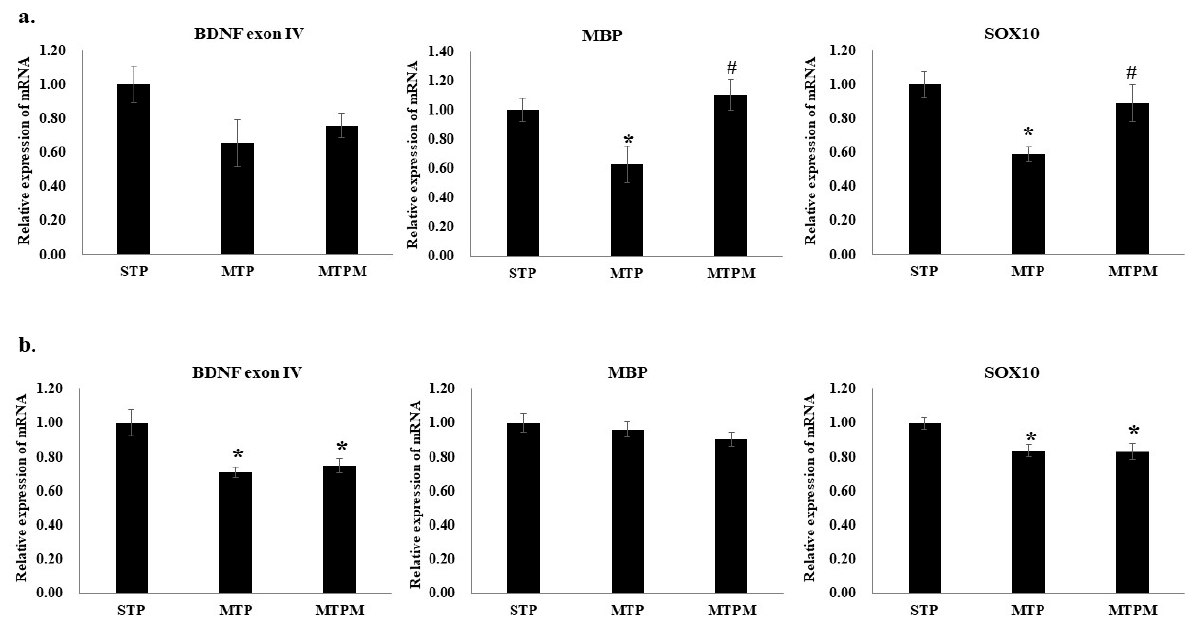
Figure 1. Methotrexate treatment resulted in myelination-related protein mRNA expression alteration; however, melatonin recovery effects were significantly observed in cortex but not hippocampus. ( a ) MTX treatemnt resulted in significant down-regulation of MBP and SOX 10 mRNA expressions in brain cortex while BDNF exon IV was declined but not significatly changed. ( b ) MTX treatemnt resulted in a significant down-regulation of BDNF exon IV and SOX10 mRNA expression while MBP slightly decreased without significance in the hippoccampus (*: p < 0.05 vs. STP; #: p < 0.05 vs. MTP).